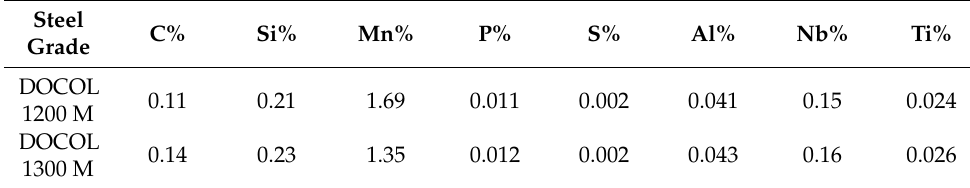
Table 3. Stale DOCOL composition (own research).